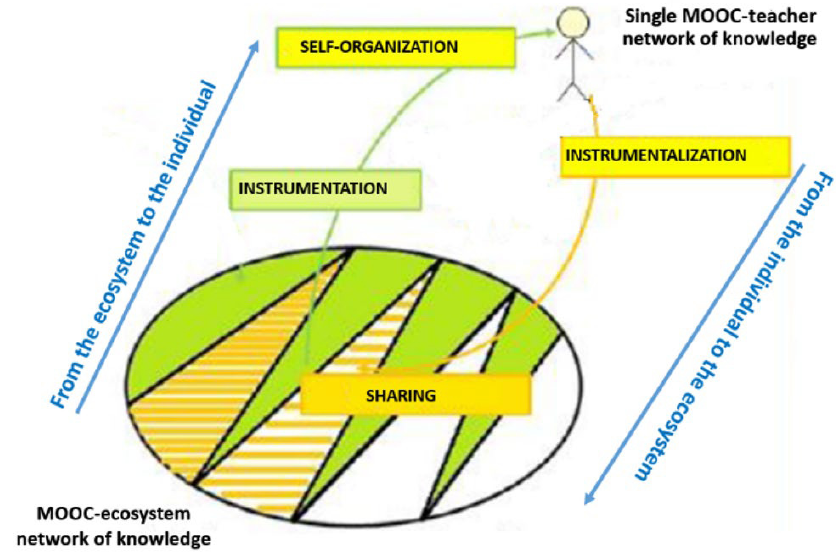
Figure 4. The double learning process taken from [22] (pp. 848).